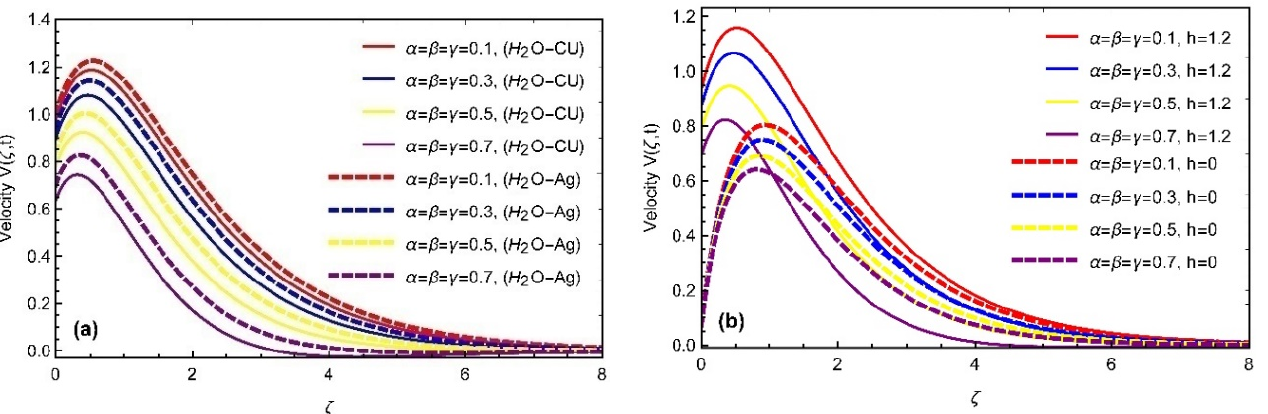
Figure 5. Momentum fields for ( a ) α , β , γ and ( b ) α , β , γ and h with α = β = γ = 0.6, Pr = 6.0, Figure 5. Momentum fields for (a) 𝛼, 𝛽, 𝛾 and (b) 𝛼, 𝛽, 𝛾 𝑎𝑛𝑑 ℎ with 𝛼 = 𝛽 = 𝛾 = 0.6, 𝑃𝑟 = Sc = 1.6, Gr = 6.2, Gm = 4.3, h = 0.5, K = 3.2, M = 1.2, θ 1 = θ 2 = π 6.0, 𝑆𝑐 = 1.6, 𝐺𝑟 = 6.2, 𝐺𝑚 = 4.3, ℎ = 0.5, 𝐾 = 3.2, 𝑀 = 1.2, 𝜃 (cid:2869) = 𝜃 (cid:2870) = (cid:3095) Figure 5. Momentum fields for (a) 𝛼, 𝛽, 𝛾 and (b) 𝛼, 𝛽, 𝛾 𝑎𝑛𝑑 ℎ with 𝛼 = 𝛽 = 𝛾 = 0.6, 𝑃𝑟 = Figure 5. Momentum fields for (a) 𝛼, 𝛽, 𝛾 and (b) 𝛼, 𝛽, 𝛾 𝑎𝑛𝑑 ℎ with 𝛼 = 𝛽 = 𝛾 = 0.6, 𝑃𝑟 = 1.0 . 6.0, 𝑆𝑐 = 1.6, 𝐺𝑟 = 6.2, 𝐺𝑚 = 4.3, ℎ = 0.5, 𝐾 = 3.2, 𝑀 = 1.2, 𝜃 (cid:2869) = 𝜃 (cid:2870) = (cid:3095) 6.0, 𝑆𝑐 = 1.6, 𝐺𝑟 = 6.2, 𝐺𝑚 = 4.3, ℎ = 0.5, 𝐾 = 3.2, 𝑀 = 1.2, 𝜃 (cid:2869) = 𝜃 (cid:2870) = (cid:3095) 1.0 . 1.0 .